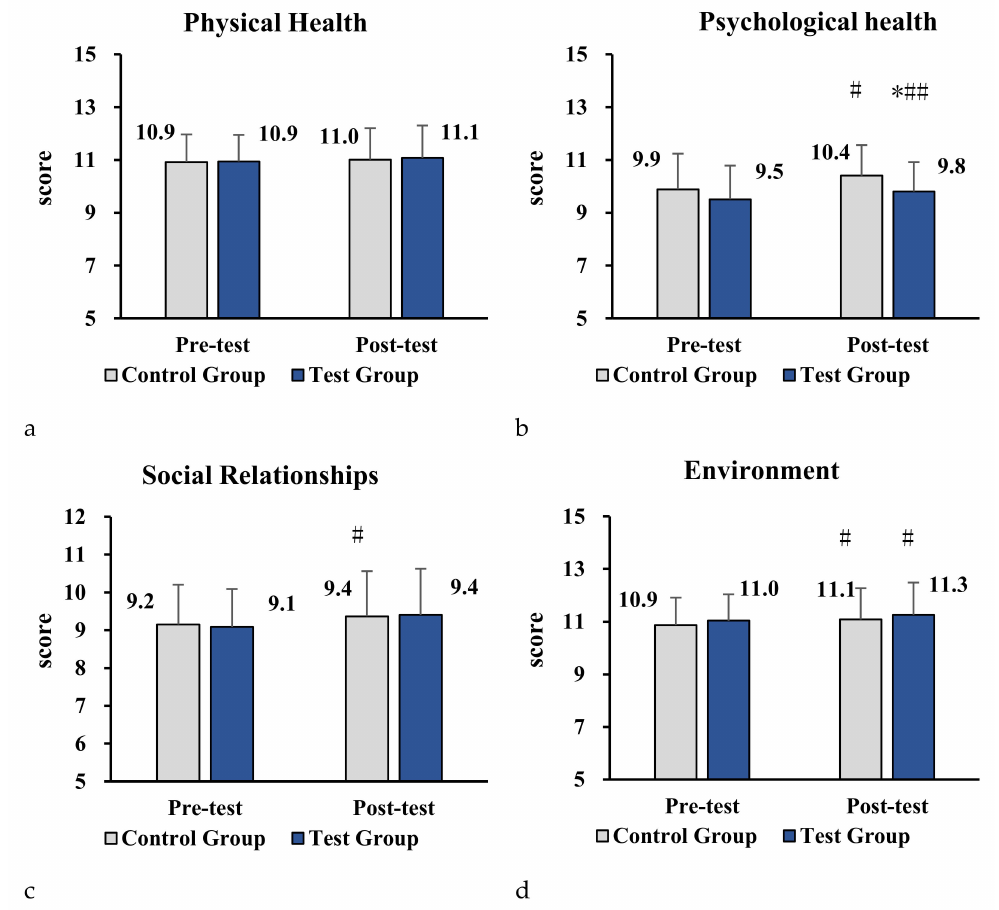
Figure 4. ( a–d ) Impact of parent–child physical activity program on sub-scales of physical health, psychological health, social relationships, and environment in the two groups. Note. Compared with the control group, * denotes p < 0.05, ** denotes p < 0.01. Compared with pre-test, # denotes p < 0.05, ## denotes p <